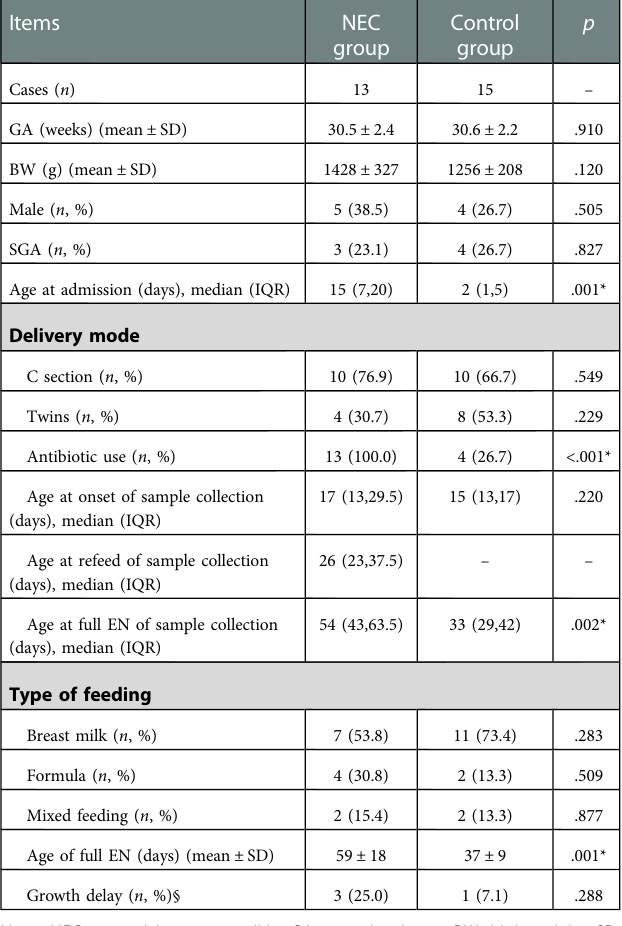
TABLE 1 Demographic and clinical